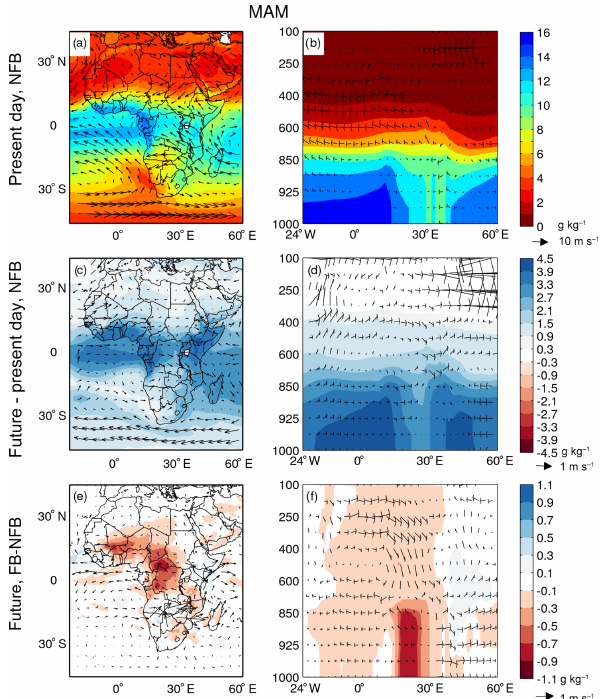
Figure 9. Same as Fig. 8 but for